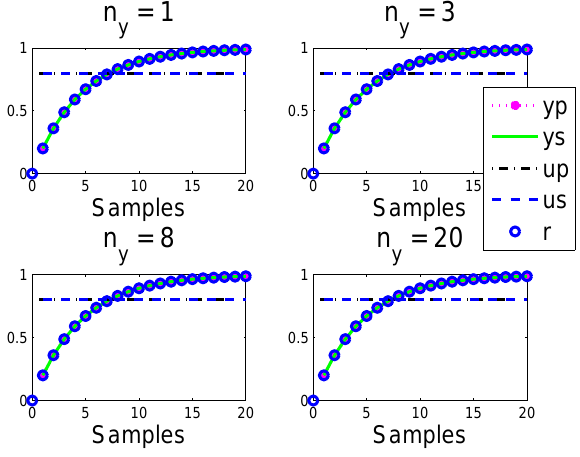
Figure 4. Closed-loop PFC input and output us; ys responses overlaid with predictions up; yp made at the first sample for a = (cid:26) ; here, ys = yp; us = up .